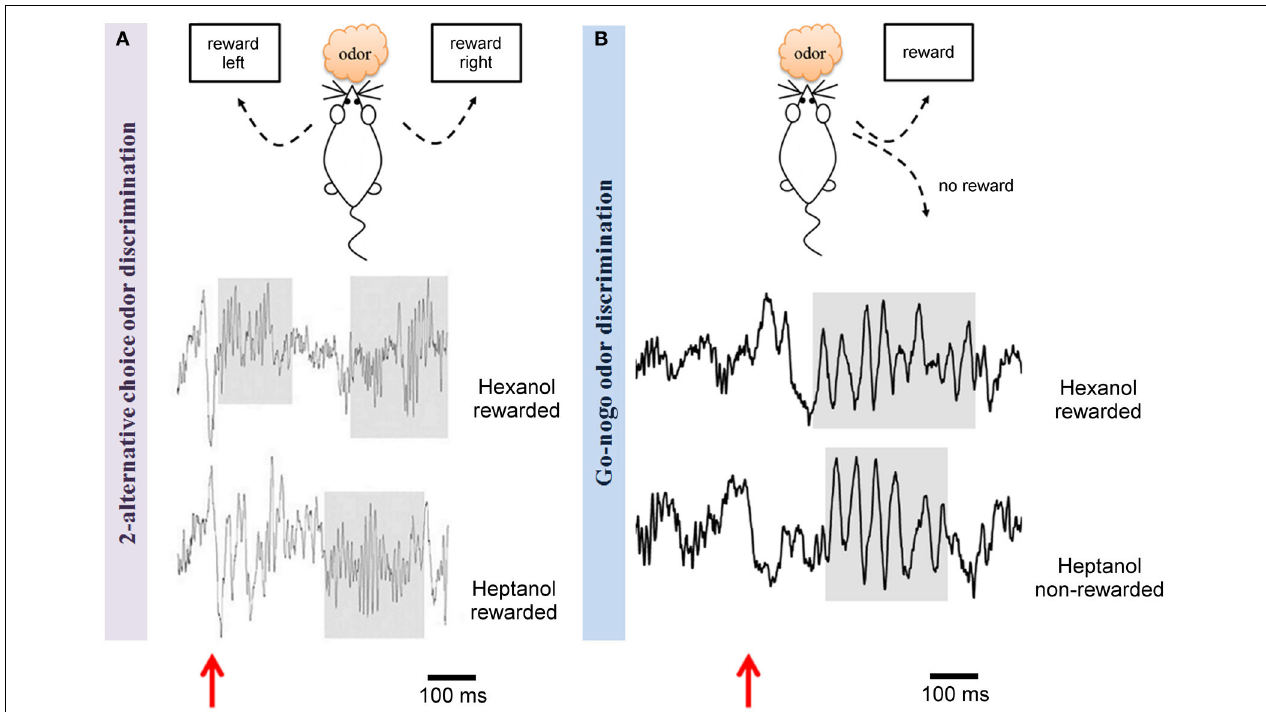
FIGURE 2 | Odor discrimination in two different behavioral tests led to distinct rhythms in the olfactory bulb. Example of raw LFP traces recorded in the olfactory bulb during a criterion session of discrimination between two alcohols (hexanol and heptanol) in two different paradigms: (A) a two-alternative choice test (Beshel et al., 2007) or (B) a Go/No-Go test (Martin et al., 2007). The two tests are schematized on the top. The main difference is that both odors are rewarded in the 2 alternative-choice whereas one odor is not rewarded in the Go/No-Go. In both cases, the same odor concentration is delivered. Odorants are generated in glass